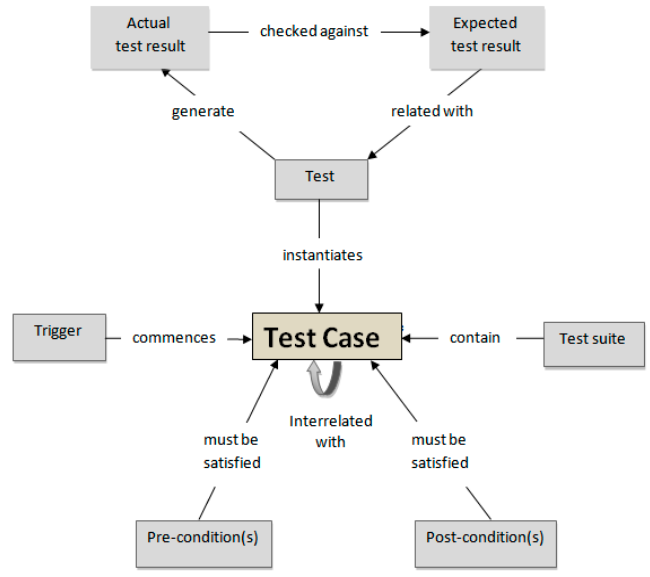
Figure 6. Test case mode.